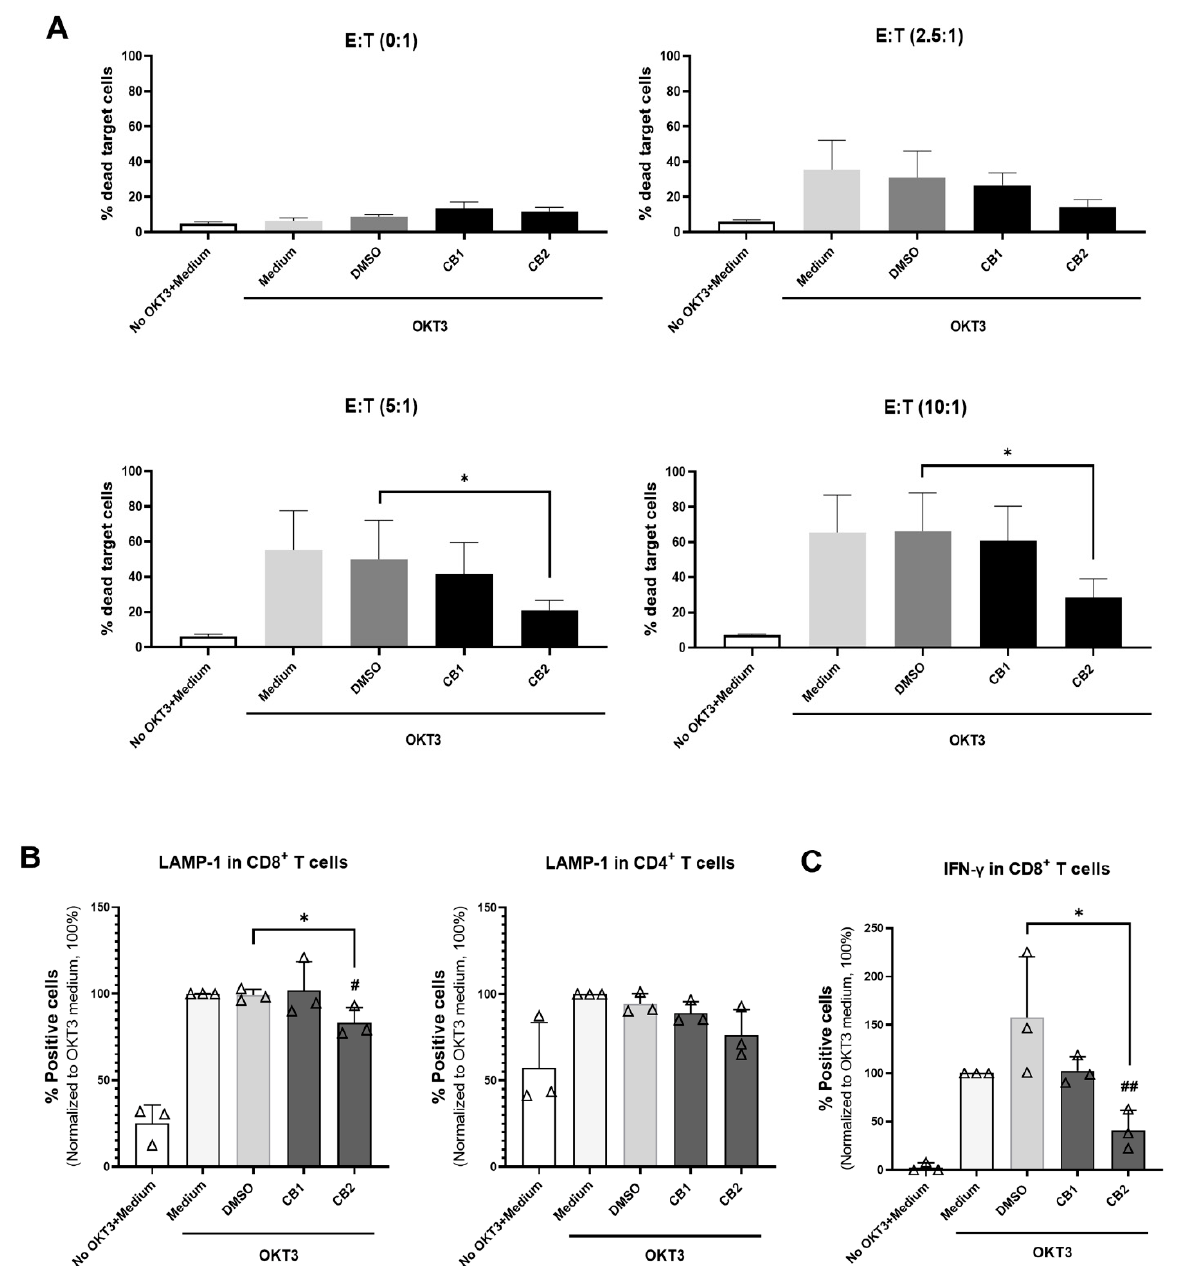
Figure 6. Effect of CB1 and CB2 agonists on cytotoxic function of T cells. We used CFSE-labeled P815 cells as target cells and investigated cytotoxic activity of T cells by co-culture of PBMCs (effector cells) with anti-CD3 mAb OKT3 and P815 target cells at various effector to target (E:T) ratios in the presence of 20 µ M CB1 agonist ACEA or CB2 agonists GW833972A, the relevant concentration of DMSO, or medium control for 24 h. ( A ) The bar graphs report the percentage of dead target cells (CFSE + 7-AAD + ) as mean ± SD (n = 3). ( B ) The bar graphs exhibit the percentage of LAMP-1 positive in CD8 + T cells and CD4 + T cells (n = 3) and ( C ) IFN- γ - positive in CD8 + T cells (n = 3). The data were analyzed as the percentage of positive cells (% specific marker mAb staining–% isotype-matched control mAb staining). The bar graphs report the percentage of positive cells under the indicated conditions as mean ± SD. A triangle represents an individual datum. Each individual datum was normalized relative to its medium control (OKT3 + Medium) as 100%. All experiments, used